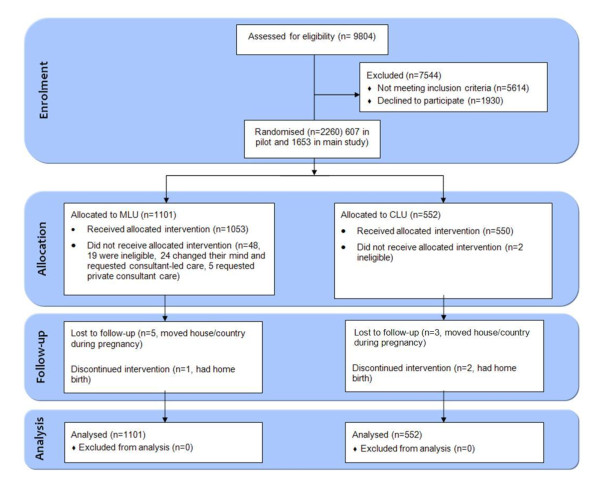
Enrolment flowchart.